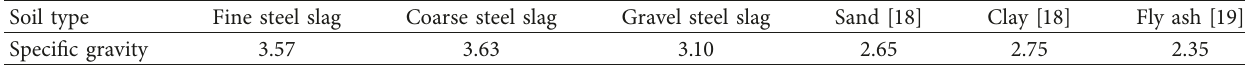
Table 4: Comparison of specific gravity between three kinds of steel slag and conventional soils.